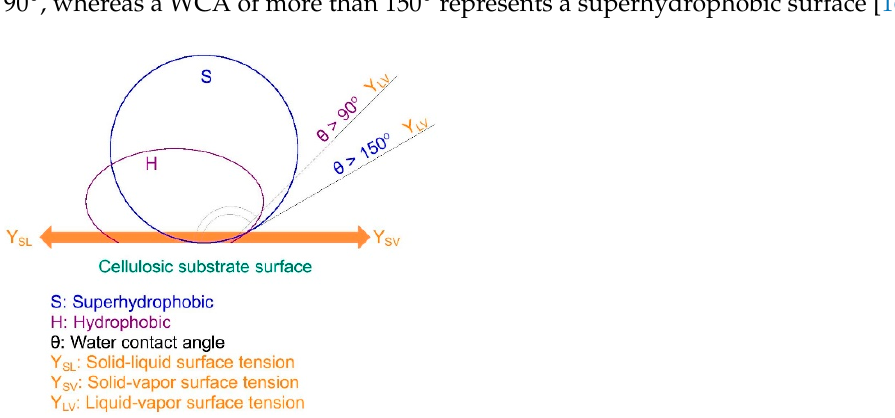
Figure 1. Illustration of hydrophobic and superhydrophobic surfaces based on water contact angle measurement.